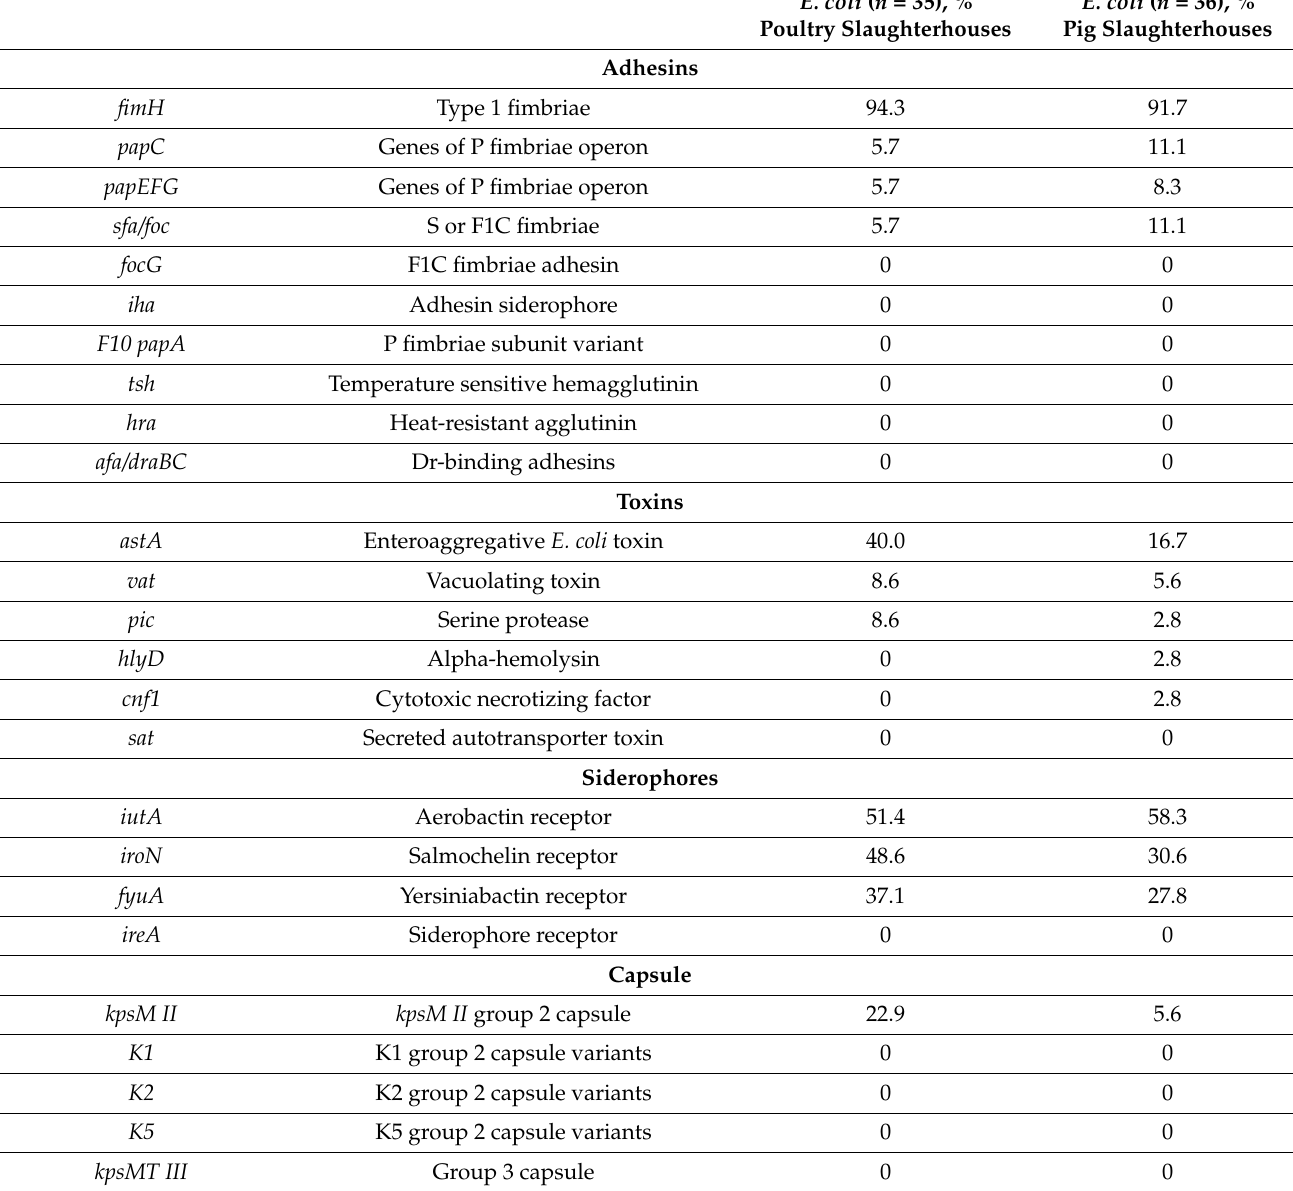
were detected. Interestingly, almost all isolates carried fimH that codes for the adhesin on type 1 pili. Of note, 40.0% of isolates from poultry slaughterhouses (14/35) carried virulence gene astA encoding the enteroaggregative E. coli heat-stable enterotoxin (EAST1), whereas this virulence genotype was less present among isolates from pig slaughterhouses (16.7%, 6/36). Nevertheless, one isolate recovered from the wastewater used for cleaning pig transport trucks carried virulence determinants coding for α -hemolysin ( hlyD ) and cytotoxic necrotizing factor ( cnf1 ). Furthermore, a high percentage of isolates was positive for different siderophores, such as aerobactin ( iutA ), salmochelin ( iroN ) and yersiniabactin ( fyuA ), whereas aerobactin was the most prevalent one. Noteworthy, the percentage of isolates carrying genes for group 2 capsule ( kpsM II ) was higher among isolates from poultry slaughterhouses (22.9%, 8/35) compared to those from pig slaughterhouses (5.6%, 2/36). Table 3. Virulence factors detected in selected E. coli isolates recovered from wastewater and process waters from poultry and pig